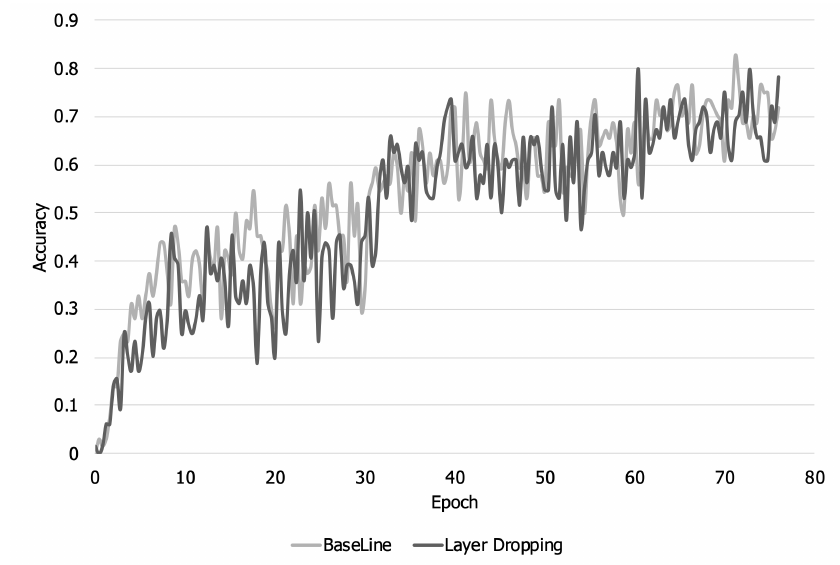
Figure 11. Training accuracy per epoch in a high bandwidth